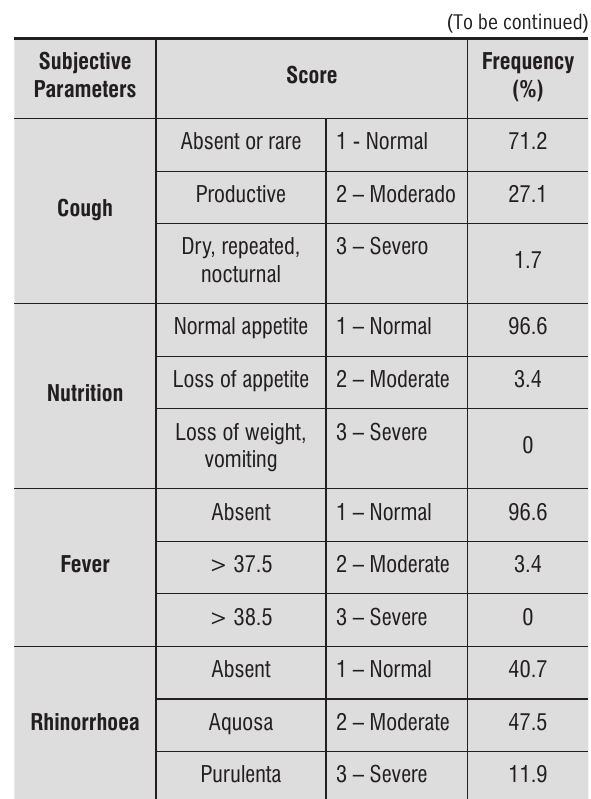
Table 4 - Frequency of children according to the score given to each parameter of the Paediatric Respi- ratory Severity